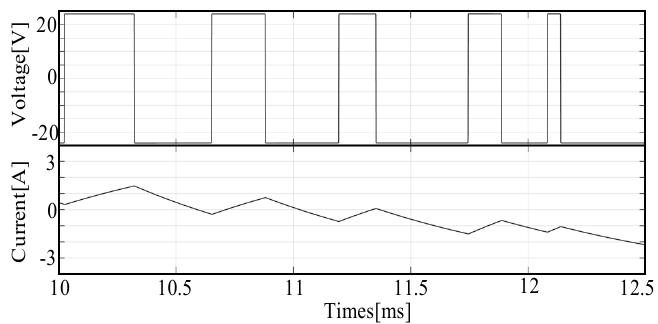
Figure 8. Enlarged waveform of Figure 7.